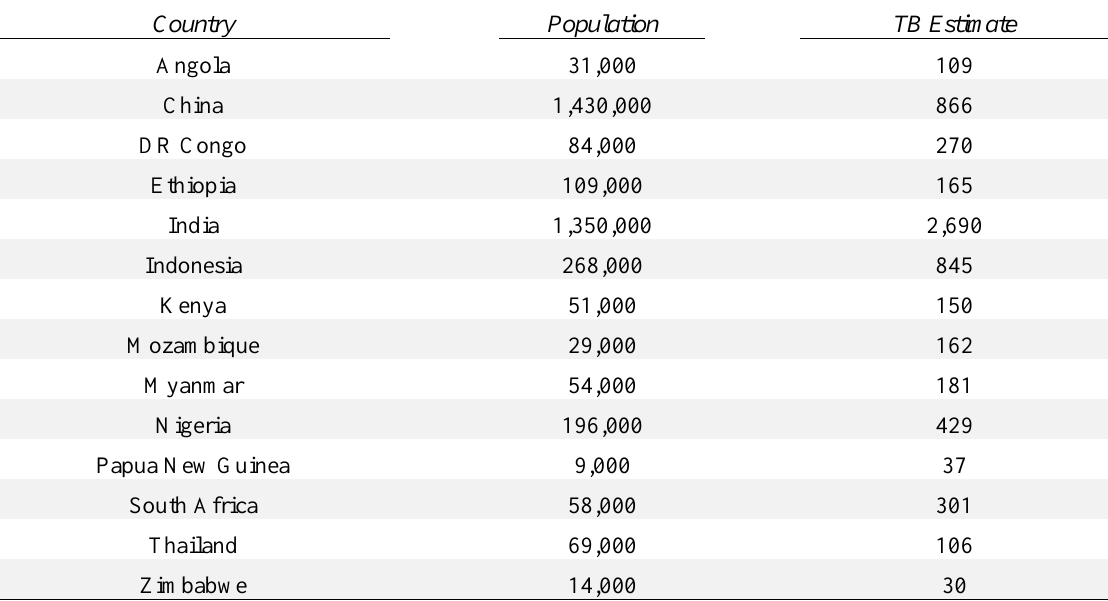
Table 1: High Burden TB Countries and Estimates of TB Burden (in